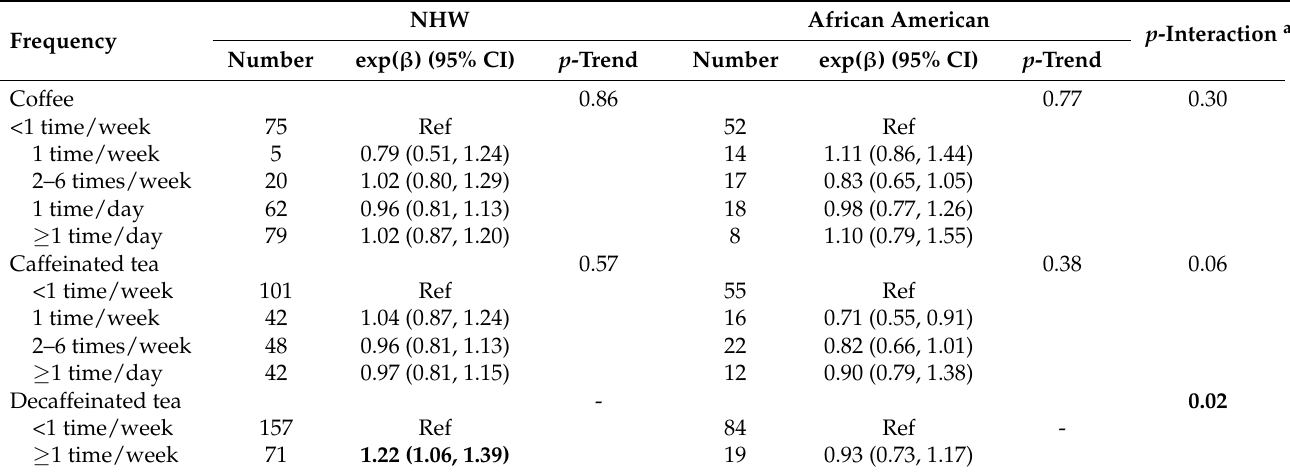
Table 4. Associations of coffee/tea intake with volumetric percent density stratified by race